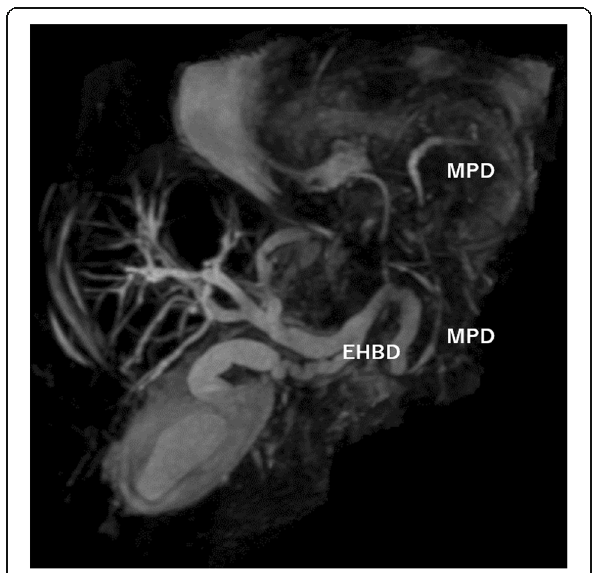
Fig. 4 Magnetic resonance cholangiopancreatography (MRCP)